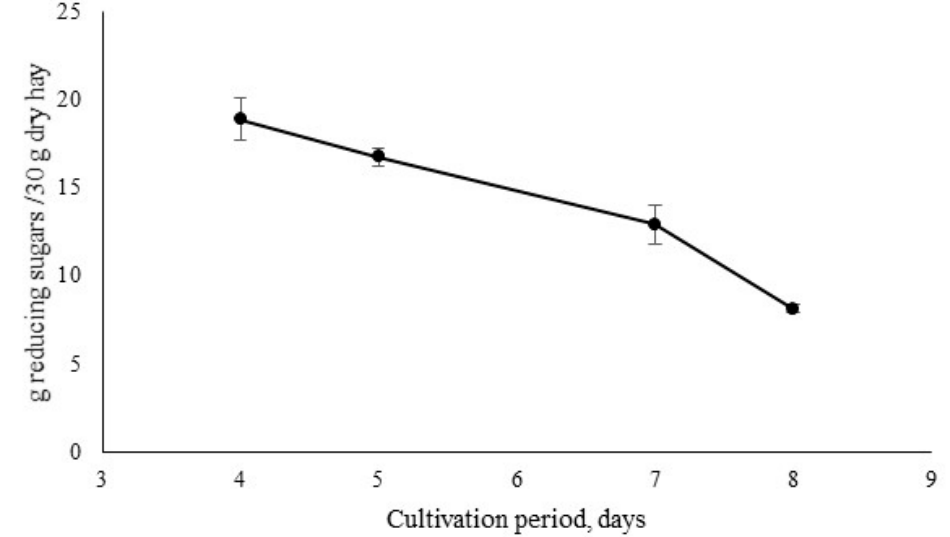
Figure 2. The amount of total reducing sugars produced after 24 h of hydrolysis from 30 g dry hay and 1 mL of enzyme cocktail that was obtained after 4, 5, 7 or 8 days of I. lacteus cultivation with hay biomass substrate as carbon source. Bars represent the average from 2 separate experimental repetitions.